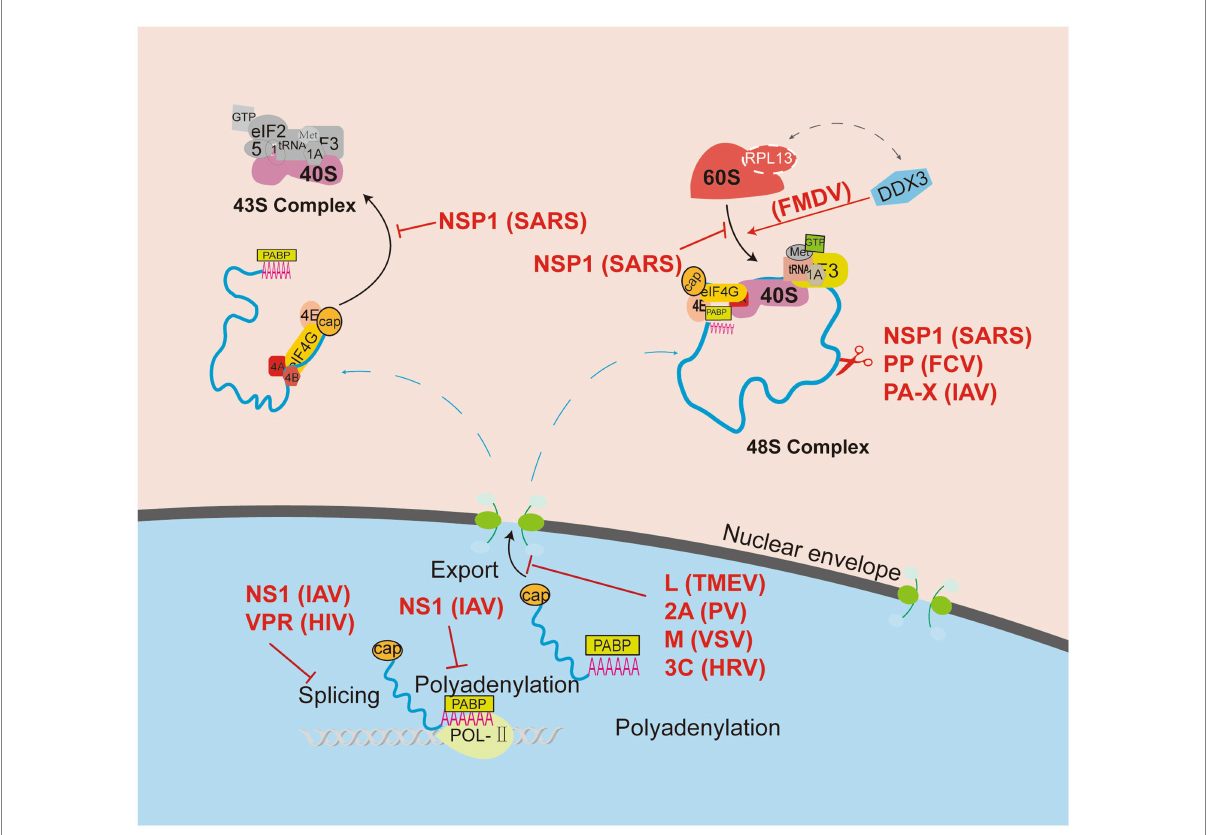
FIGURE 1 Viruses manipulate ribosomes to shut down host protein translation. Cellular mRNA biogenesis begins in the nucleus, and viruses use various mechanisms to block the translation of host mRNA, including remodeling of the host mRNA library, inhibiting host mRNA transport from the nucleus, and blocking ribosomal recruitment of eukaryotic translation initiation factor (eIF). Consequently, viruses can block ribosomal mRNA entry channels or inhibit the binding of ribosomal size subunits to prevent the translation of host